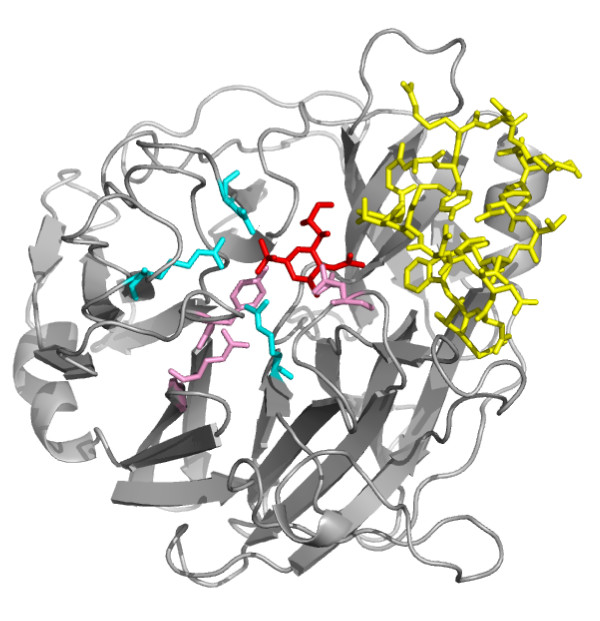
Functional residues of sialidase 3SIL. Catalytic and binding residues annotated in Swiss-Prot are highlighted in pink and cyan. The inhibitor (found in structure 1DIL) is highlighted in red. The long loop revealed by the structural word analysis is highlighted in yellow.